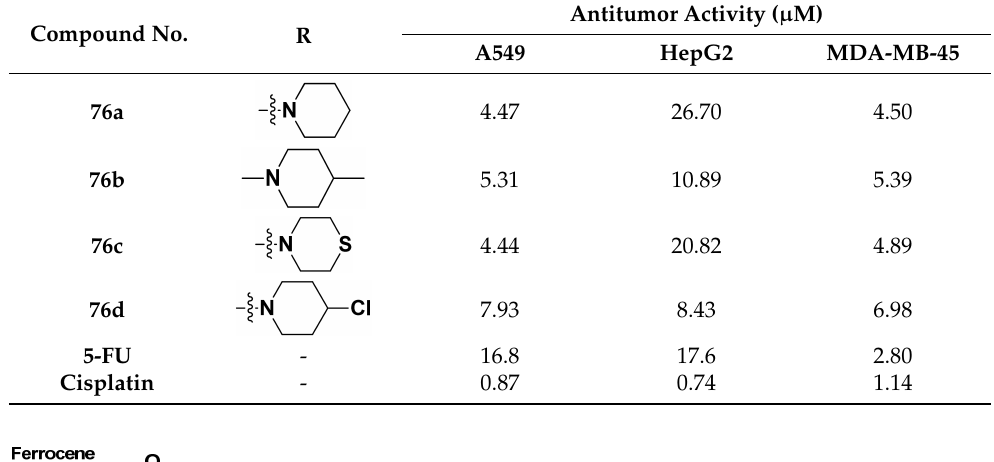
Table 62. In vitro cytotoxic activities of ferrocene containing pyrazolyl hybrid compounds 76 ( a – d ). Compound No.